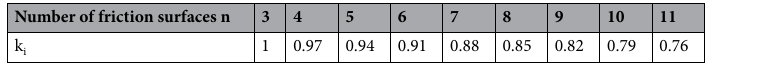
Table 1. Values of coefficient k i10